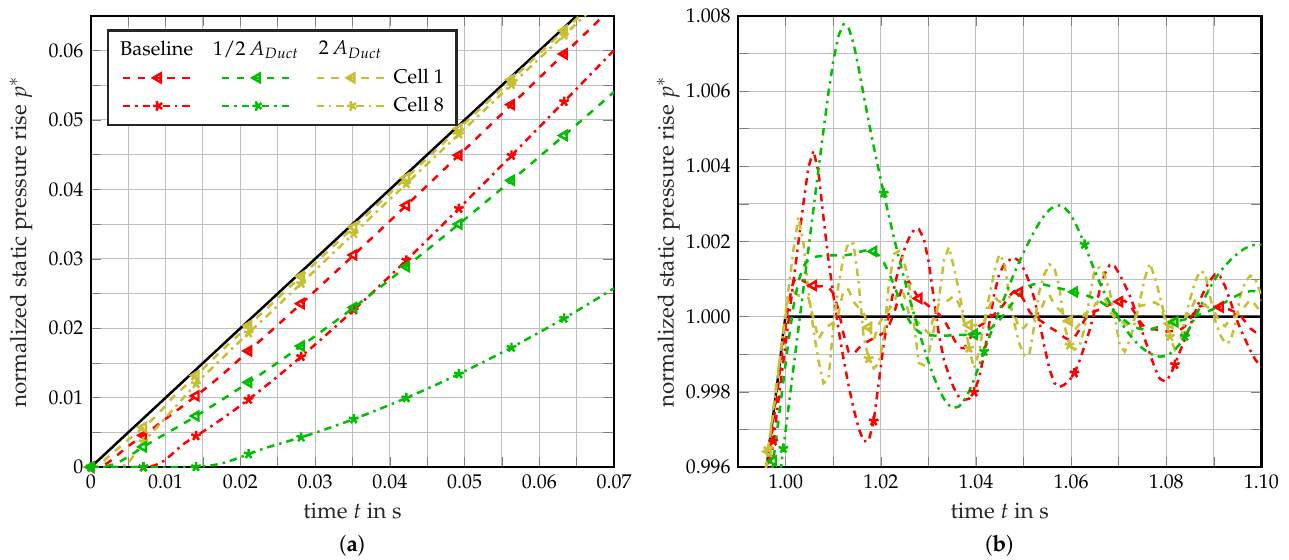
Figure 9. Scaling of duct cross-sectional area A Duct using the ROM: ( a ) Start of filling process. ( b ) End of filling